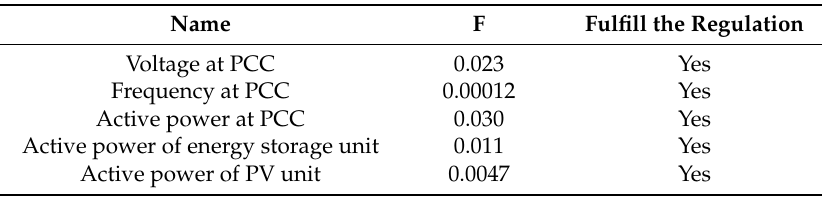
Table 5. Errors in case 2